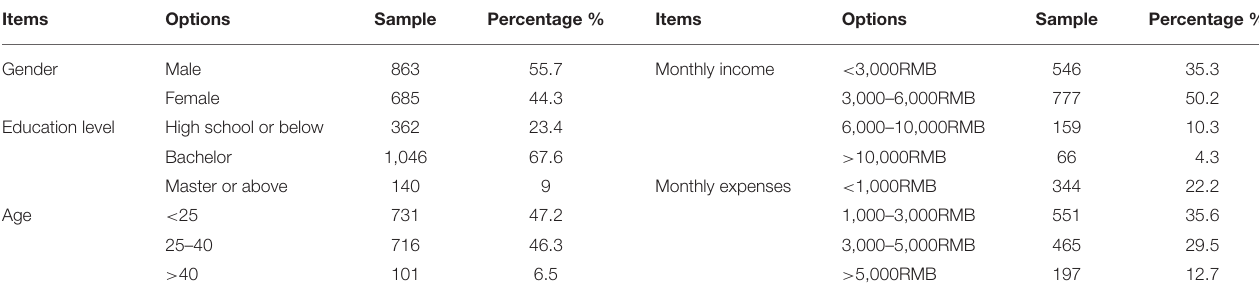
TABLE 1 | Demographic information ( N =